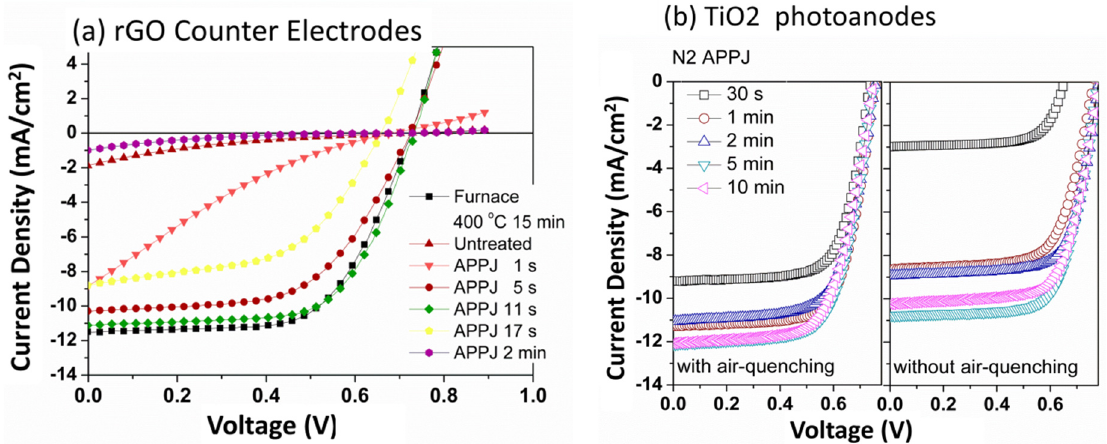
Figure 5. DSSCs with ( a ) rGO counter electrodes [27] and ( b ) nanoporous TiO 2 photoanodes sintered by APPJs for various